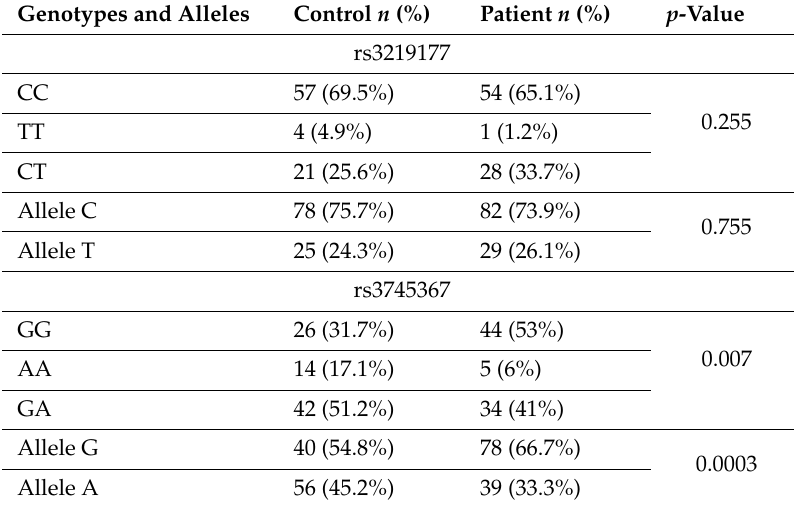
Table 4. Frequencies of RETN genotypes and alleles in males.